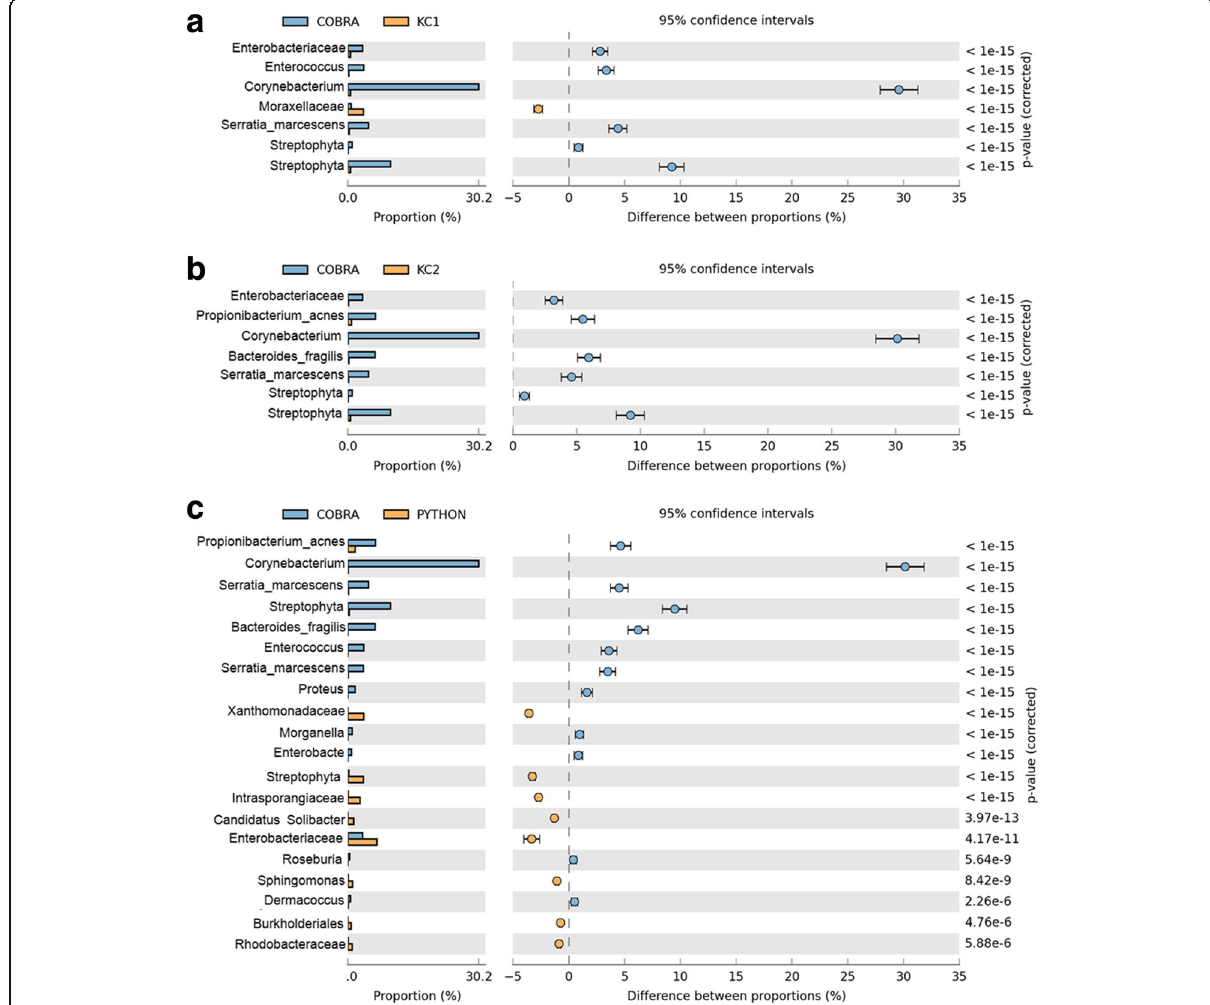
Fig. 5 Metagenomic profile comparisons of Python, Cobra and King Cobra oral samples determined using STAMP analysis. The comparison includes highly significant phylum to species level. Corrected P -values were calculated based on Fisher ’ s exact test method using Storey ’ s FDR approach. P -values < 0.05 were taken for comparison. The bar plot indicated in blue or orange shows a positive or negative difference between read proportions. Differences between samples are shown at 95% confidence intervals a Taxon comparison between Cobra and KC1 samples. Corynebacterium is present in greater abundance in Cobra and lesser abundance in KC1 with positive differences (blue dot), whereas Moraxellaceae is less abundant in Cobra and more abundant in KC1 with negative differences (yellow dot); b Comparison of Cobra and KC2. The most abundant taxon includes Corynebacterium, Bacteroides fragilis and streptophyta , all with positive proportion differences; c Comparison between Cobra and Python samples. Corynebacterium, Propionibacterium acnes and serratia marcescens are highly abundant with positive differences, whereas the species group including Xanthomonadaceae, Streptophyta and Enterobacteriaceae are in greater abundance with negative differences. Here, KC1: King Cobra 1 and KC2: King Cobra